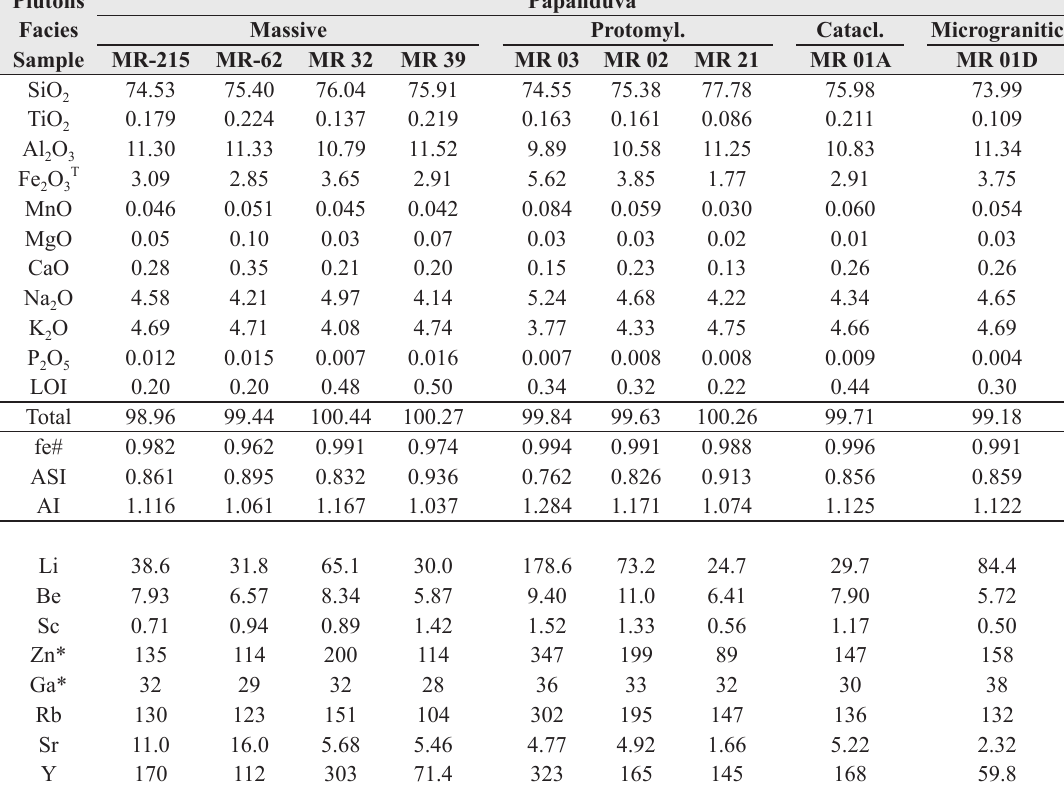
O+K O)/Al O and ASI (Alumina Saturation Index) = Al 2 2 2 3